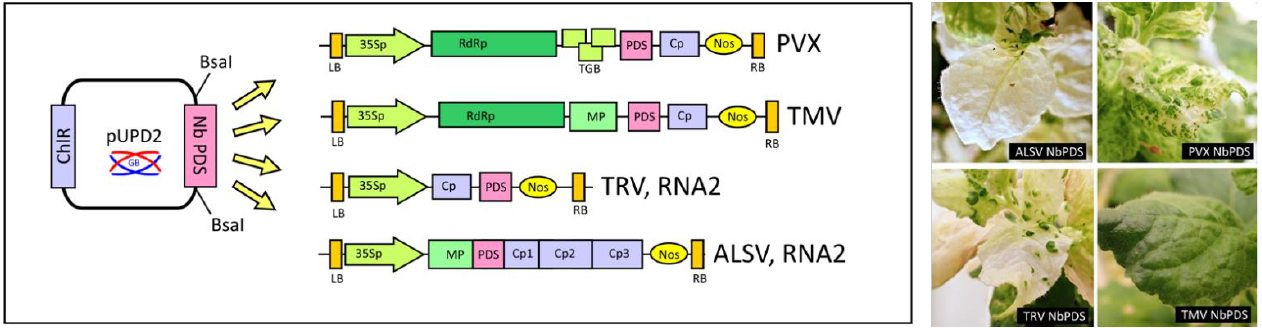
Figure 5. Schematic representation of the VIGS vector. The 206 bp long NbPDS gene fragment was first cloned into the universal domestication vector pUPD2.The PDS fragment was then used in four different GB assembly reactions to generate four infectious cDNA clones of the PVX, TMV, TRV, and ALSV viruses. LB, RB — left and right T-DNA edges; 35Sp — CaMV 35S promoter; RdRp — RNA- dependent RNA polymerase; TGB — triple gene block; PDS — fragment of Nb phytoene desaturase; CP — coat protein; Nos — A. tumefaciens nopaline synthase terminator; MP — movement protein. The diagram is not drawn to scale. Leaves of Nicotiana benthamiana showing the phenotype of photo- bleaching and symptoms of viral infection at 20 dpi.